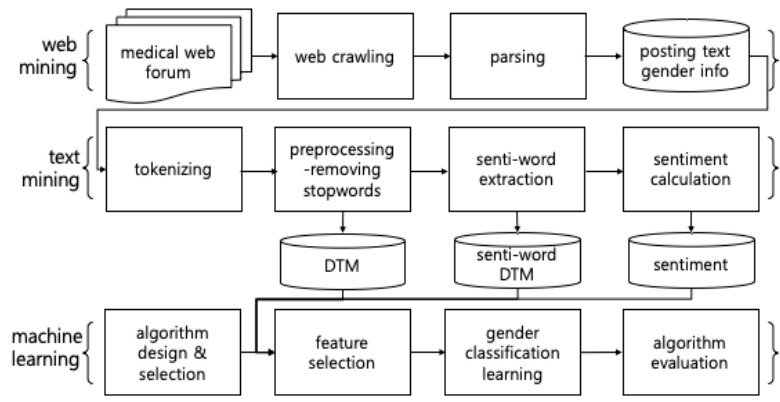
Figure 1. Gender classification model for medical web forum.